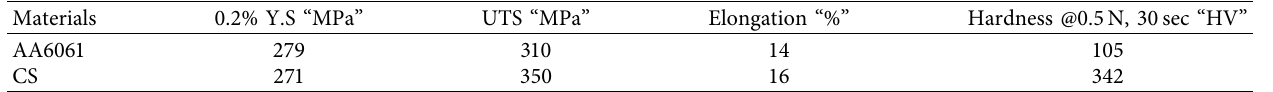
Table 2: Mechanical properties of BMs.